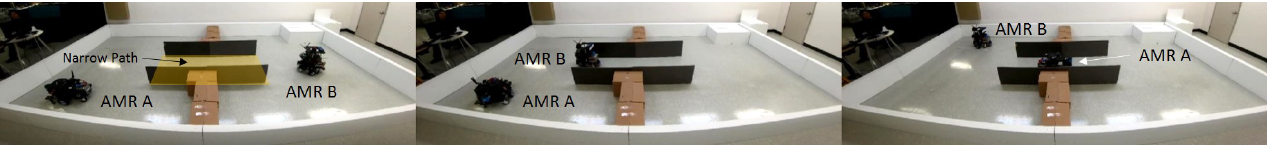
Figure 10. AMR A and B in the narrow path under the region filter.